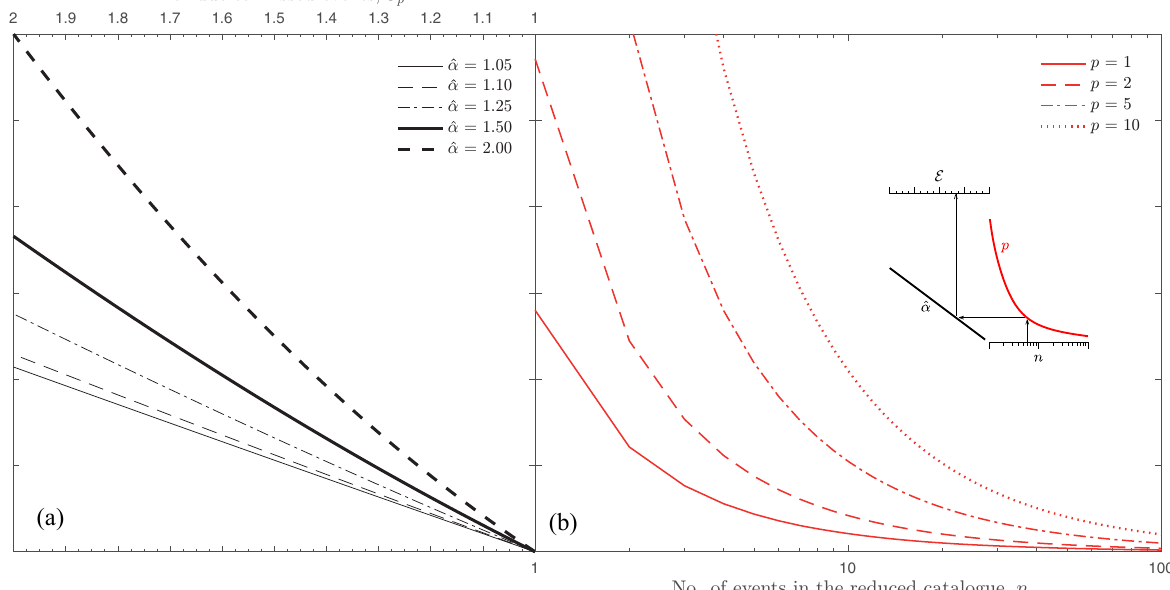
100 oN . of events in the reduced catalogue, n